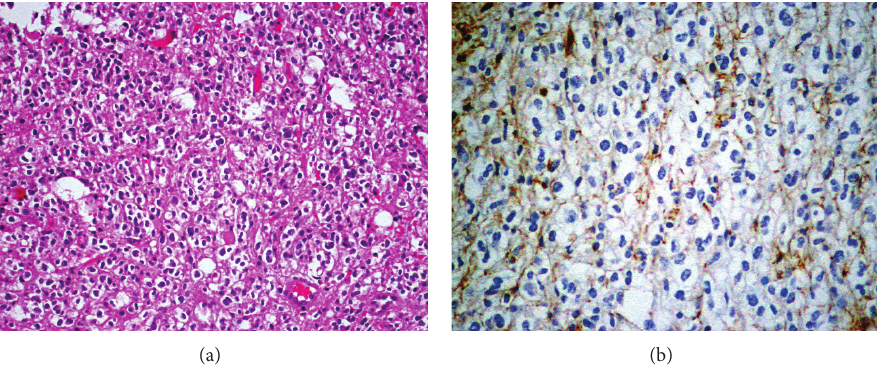
Figure 3: Histological examination. (a) Hematoxylin/Eosin coloration, with × 20 magnification, reveals moderately cellular neoplasm, consisting of cells with round nuclei and perinuclear light halo. (b) GFAP coloration, with × 40 magnification, reveals focal immunoreactivity of neoplastic cells (GFAP positive, CD68 negative